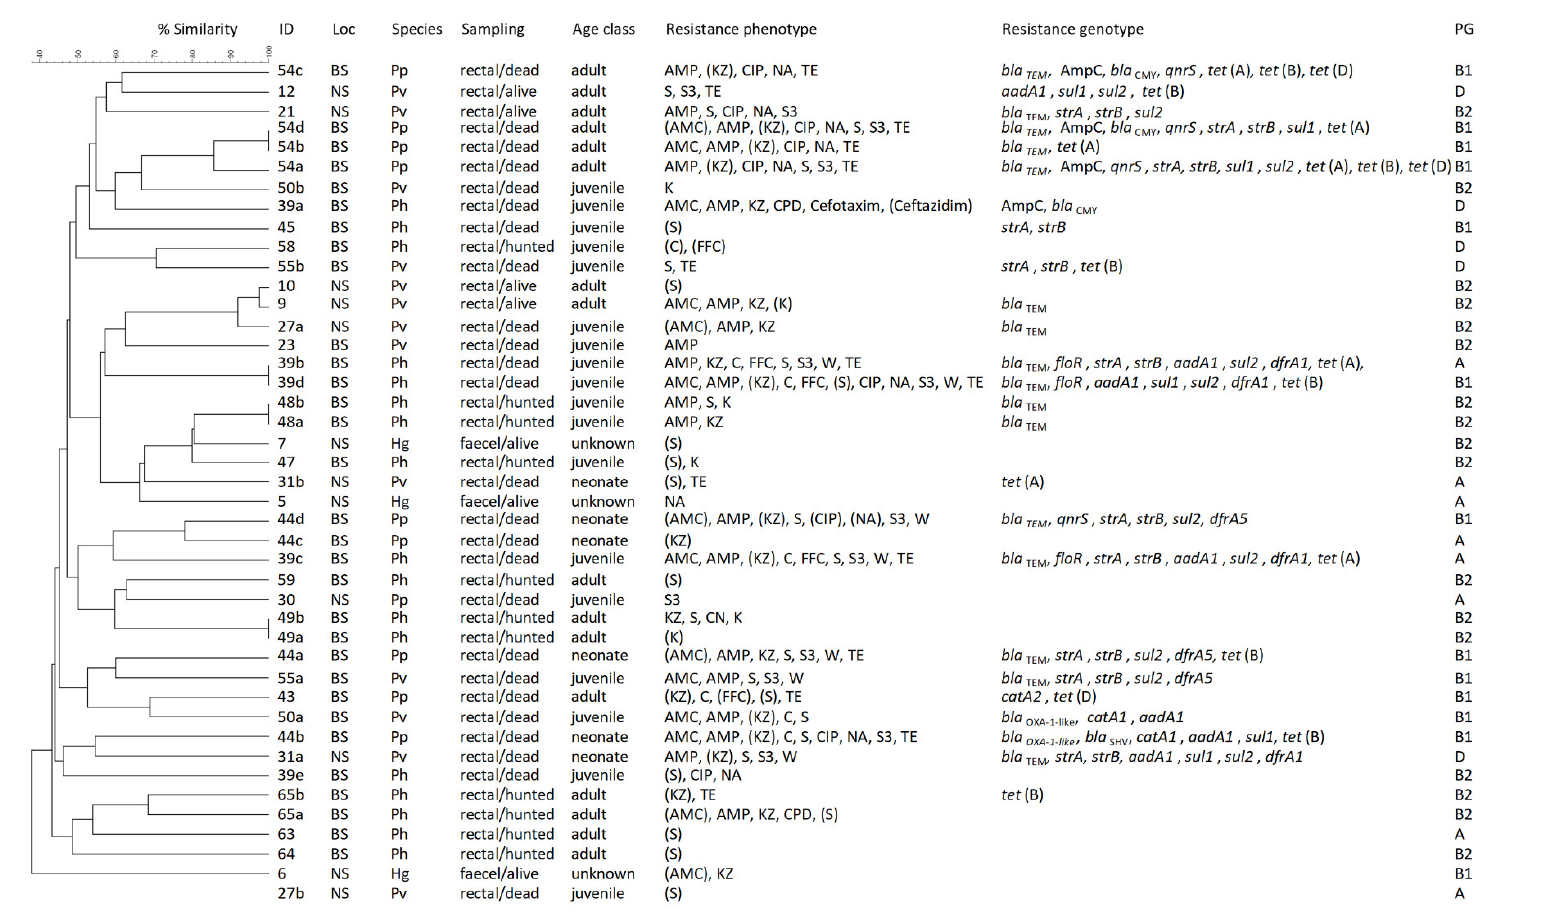
Figure 3. Overview of the pheno- and genotypes of E. coli isolates from free-ranging marine mammals. The dendrogram is shown containing 42 isolates; one isolate was not typeable. For all isolates, the sampling location, the species, the sampling method, the age class, the resistance pheno- and genotypes, and the phylogenetic group are listed. Locations: NS = North Sea, BS = Baltic Sea. Species: Pp = harbour porpoise, Pv = harbour seal, Ph = ringed seal, Hg = grey seal. Resistance phenotype: AMC = amoxicillin/clavulanic acid, AMP = ampicillin, KZ = cefazolin, CPD = cefpodoxime, C = chloramphenicol, FFC = florfenicol, S = streptomycin, CN = gentamicin, K = kanamycin, CIP = ciprofloxacin, NA = nalidixic acid, S3 = compound sulfonamide, W = trimethoprim, TE = tetracycline. Antimicrobials in brackets indicate intermediate resistance.